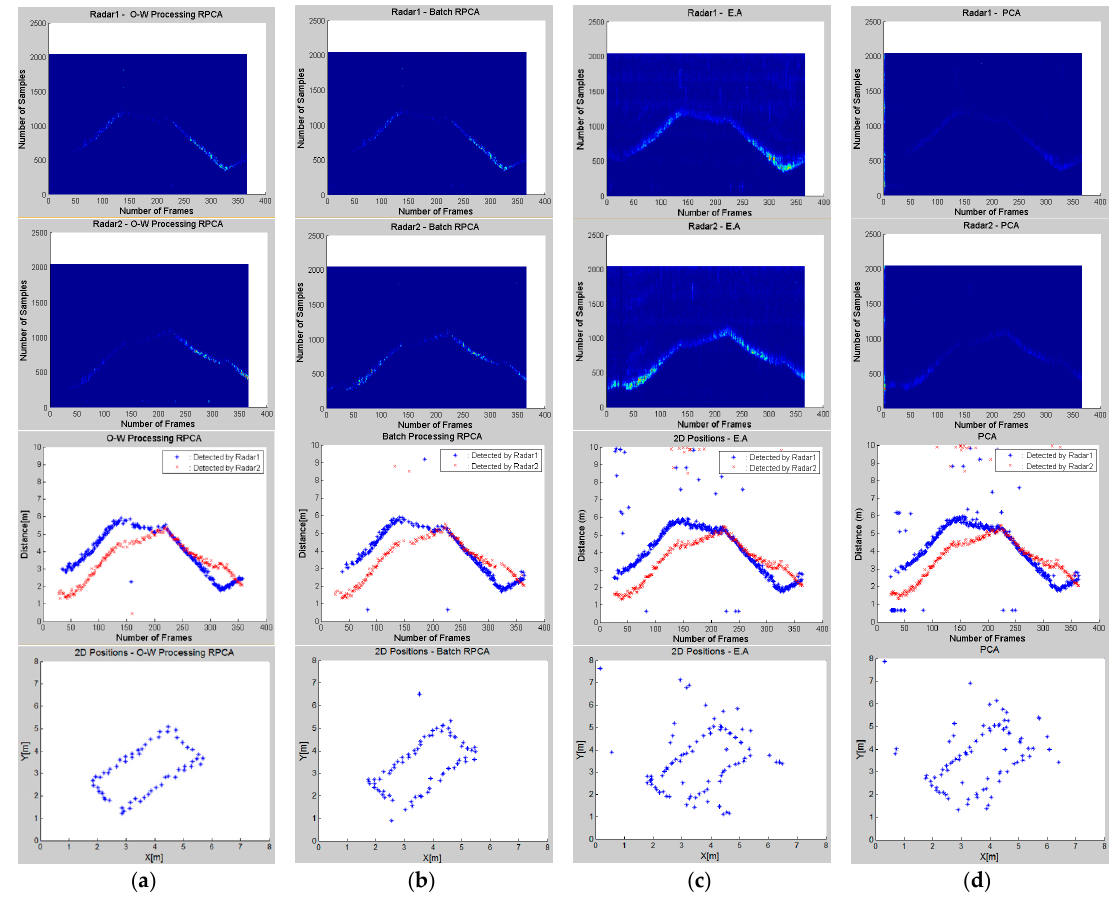
Figure 7. Clutter-free signals of the 2 radars, their respective detection results and the resulting 2D positioning given by different clutter removal techniques: Column ( a ) O-W processing RPCA; Column ( b ) Batch Processing RPCA; Column ( c ) EAM; Column ( d ) PCA.